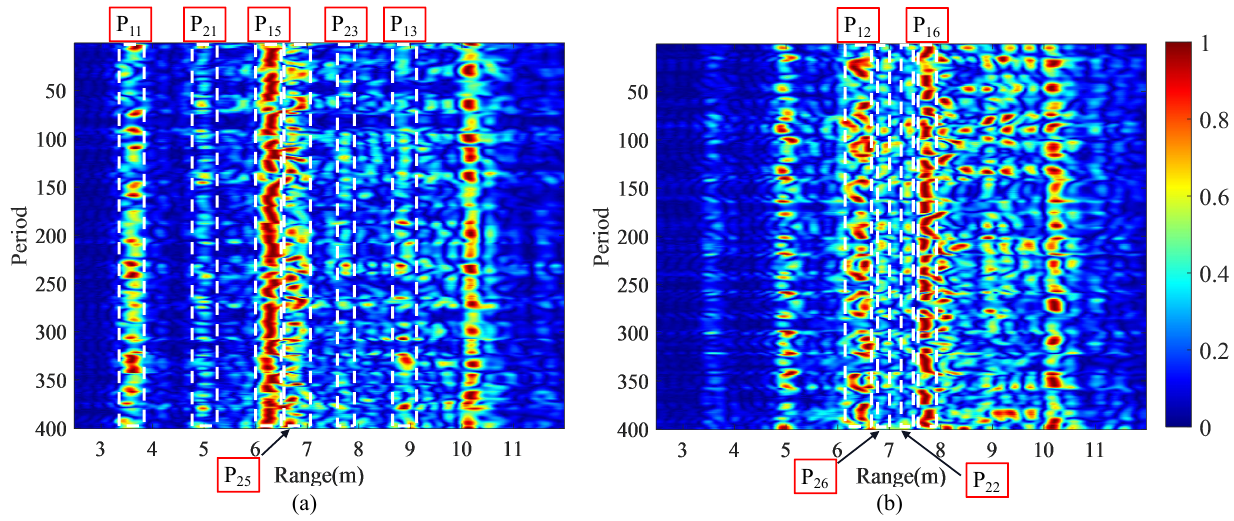
Figure 12. Dual-view range profiles for double target. ( a ) Range profile of View 1. ( b ) Range profile of View